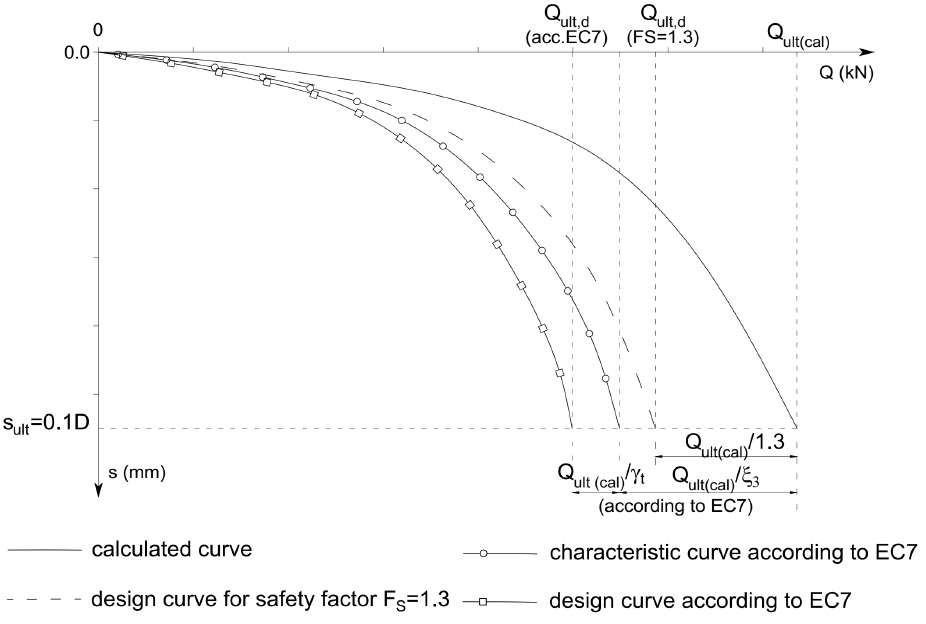
Figure 11: Concept for generation of safe design